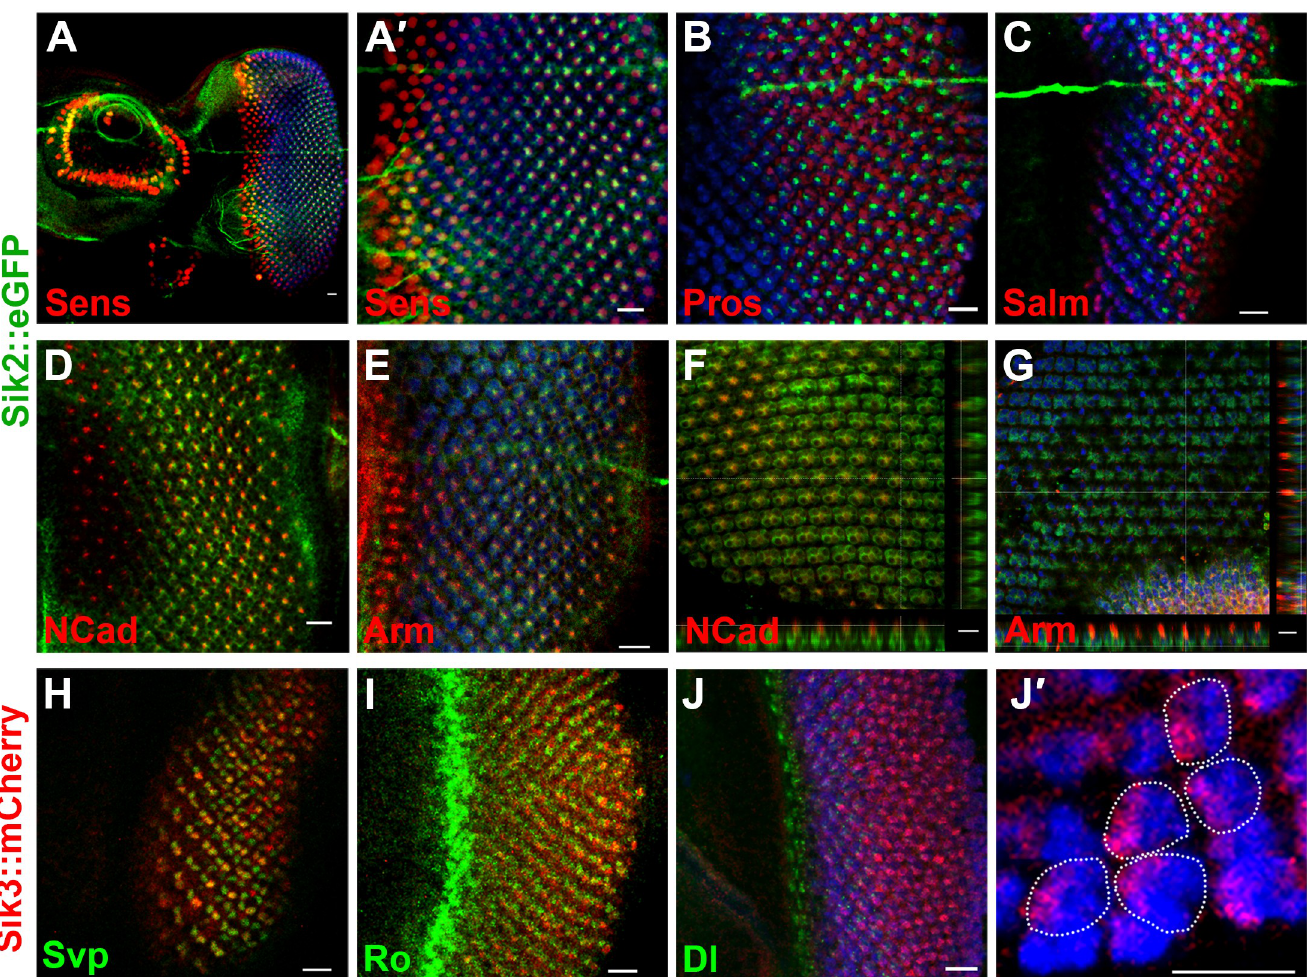
Fig 4. Expression profile of Sik2 and Sik3 in the developing retina. A, A 0 and J are maximum projections; the rest of the acquisitions are single sections. A, A 0 , B, C, D, E, H, I, J, J 0 are 3 rd instar larval eye disc. F, G are ~30% pupal retinae. Wherever used, Elav appears in blue, marking neural cells. (A-G) Sik2::eGFP transgenics. Sik2 is shown in green (A-A 0 ), Senseless (Sens) is shown in red, marking the photoreceptor R8. (A 0 ) Inset of (A. B) Prospero (Pros) shown in red, marking R7 and cone cells. (C) Spalt-major (Salm) shown in red, marking R3 and R4 in ommatidia immediately posterior to the morphogenetic furrow (MF) and R7 and R8 in more posterior ommatidia. (D) N-Cadherin (N-Cad) shown in red, marking Adherens Junctions (AJs) at larval stage. (E) Armadillo (Arm) shown in red, marking AJs at larval stage. (F) N-Cad shown in red, marking AJs at pupal stage. (G) Arm shown in red, marking AJs at pupal stage. (H-J 0 ) Sik3::mCherry transgenics. Sik3 shown in red (H) Seven-up (Svp) shown in green, marking R3/R4 in early ommatidia and R1/R6 in ommatidia more posterior. Sample is mid-3 rd instar larva. (I) Rough (ro) shown in green, marking R2/R5 immediately posterior to the MF. (J) Delta (Dl), the neurogenic factor shown in green. (J 0 ) Inset of J, Dl signal is not represented here. The ommatidium borders are marked with dashed line. Posterior to the right and scale bar is 10 μ m in all